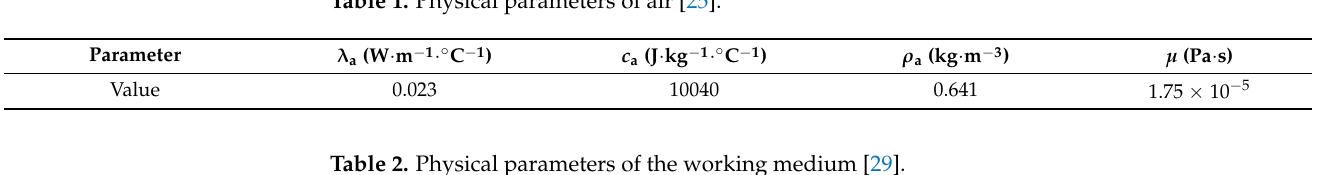
Table 1. Physical parameters of air [25].